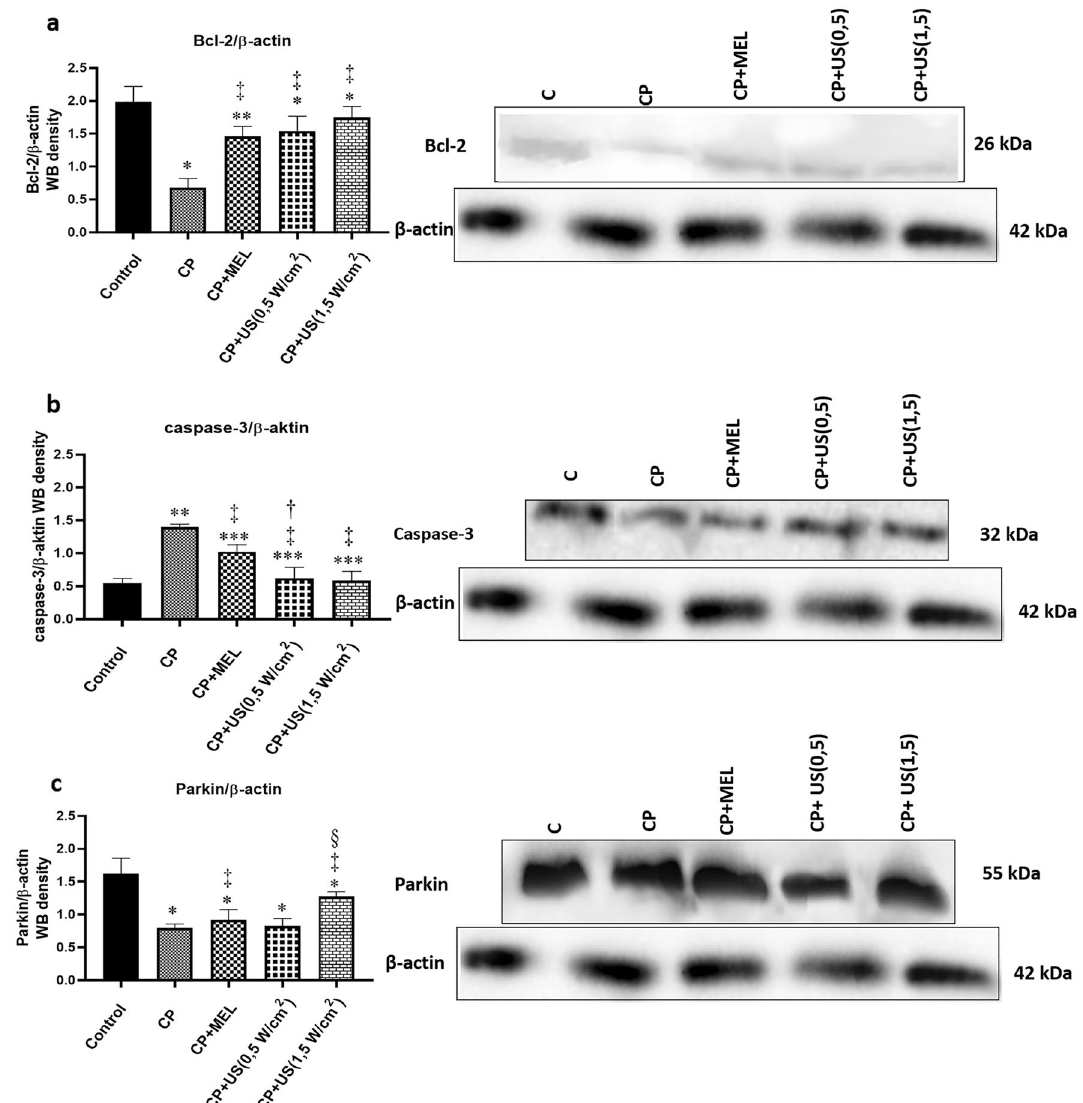
Figure 2. Results representing the alterations in protein expression levels. Representative Western blot images and the calculated protein band intensity results of the expression levels of ( a ) anti-apoptotic marker Bcl-2, ( b ) pro-apoptotic marker caspase-3 and ( c ) marker of mitophagy Parkin proteins, analyzed by ImageJ compared to that of β-actin. The represented Western blot images for each protein investigated were cropped from different blots, where same exposure was used for visualization. The full-length blots can be seen in Supplementary Fig. S1. The samples were derived from the same experiment and the blots were processed in parallel. C, control group; CP, cisplatin administered group; CP + US 0.5 W/cm 2 , cisplatin administered and 0.5 W/cm 2 US treated group; CP + US 1.5 W/cm 2 , cisplatin administered and 1.5 W/cm 2 US treated group; CP + MEL, cisplatin administered and melatonin treated group. Data were represented as mean ± SEM. The degree of significance was symbolized by an asterisks (*) for the comparison of all groups with respect to the control group; by a double daggers (‡) for the comparison of the treatment groups with respect to the cisplatin administered group; by a daggers (†) for the comparison of ultrasound treated groups with respect to the melatonin administered group and by a section (§) for the comparison of 1 MHz 1.5 W/cm 2 US treated group with respect to the 1 MHz 0.5 W/cm 2 US treated group (* p < 0.05, ** p < 0.01, *** p < was significantly lower in 1 MHz 0.5 W/cm 2 US treatment group ( p < 0.05) in comparison to that of melatonin administration. Figure 2c shows the protein expression levels of Parkin/β-actin in the experimental groups. Parkin is a pro- tein that takes role in the ubiquitination of mitochondrial outer membrane proteins and is known to play an important role in the destruction of the damaged mitochondria 19 ; therefore, gives information about the induc- tion of mitophagy. As can be seen in Fig. 2c, the expression level of Parkin protein was significantly decreased in cisplatin administered group ( p < 0.05) in comparison to that of control. The levels of Parkin protein were